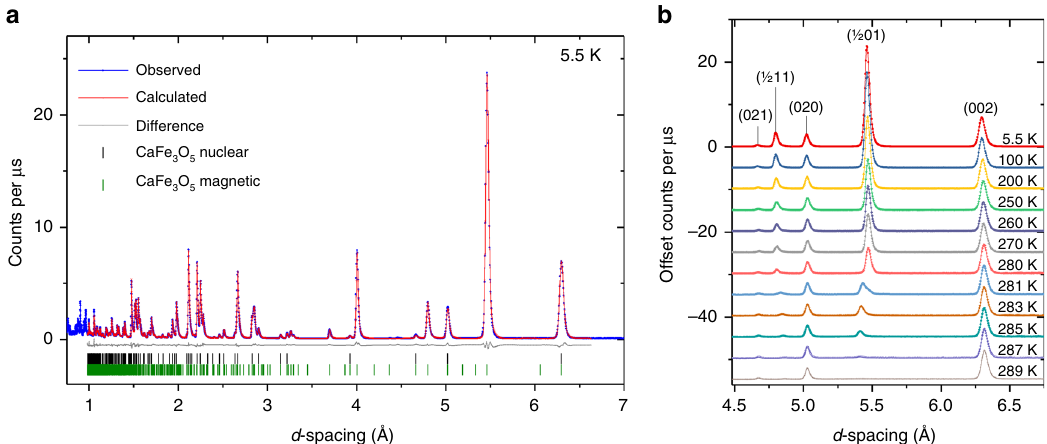
Fig. 4 Neutron powder diffraction measurements of CaFe 3 O 5 . a Rietveld re fi nement of sample A at 5.5 K shown against the 90° detector bank of the WISH neutron diffractometer 19 . b Evolution of the magnetic re fl ections with temperature.